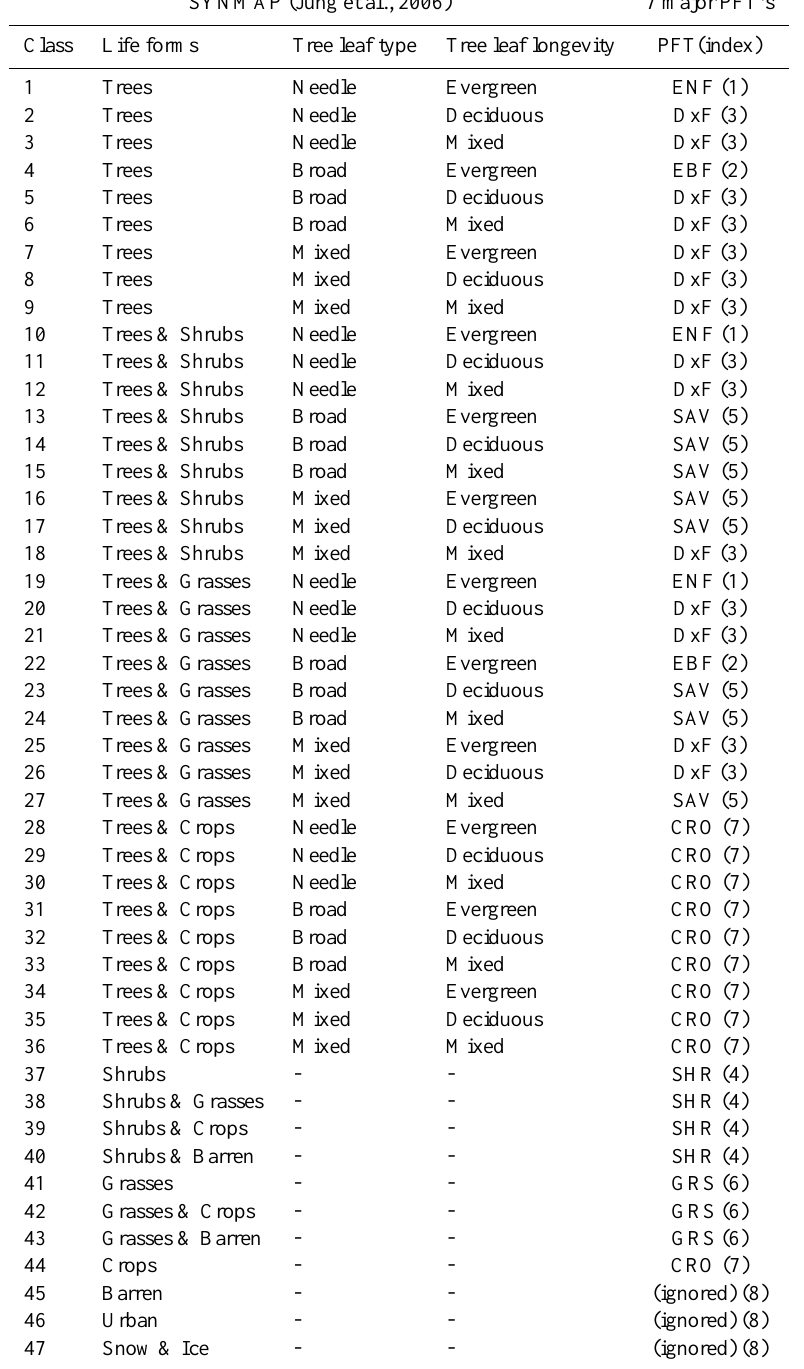
Table 1. SYNMAP (Jung et al., 2006) land cover classification and its aggregation into seven major PFTs. See Table 2 for the descriptive abbreviations used for the